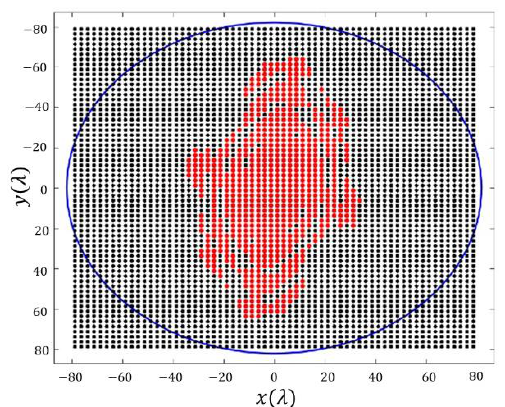
Figure 17. Layout of the antenna array with an inclusion of 5 × 5-element subarrays and by deleting the low-excited elements ( |𝐼| 𝑚𝑎𝑥 /|𝐼| 𝑚𝑖𝑛 ) = 46.81). Final number of array elements: 695.